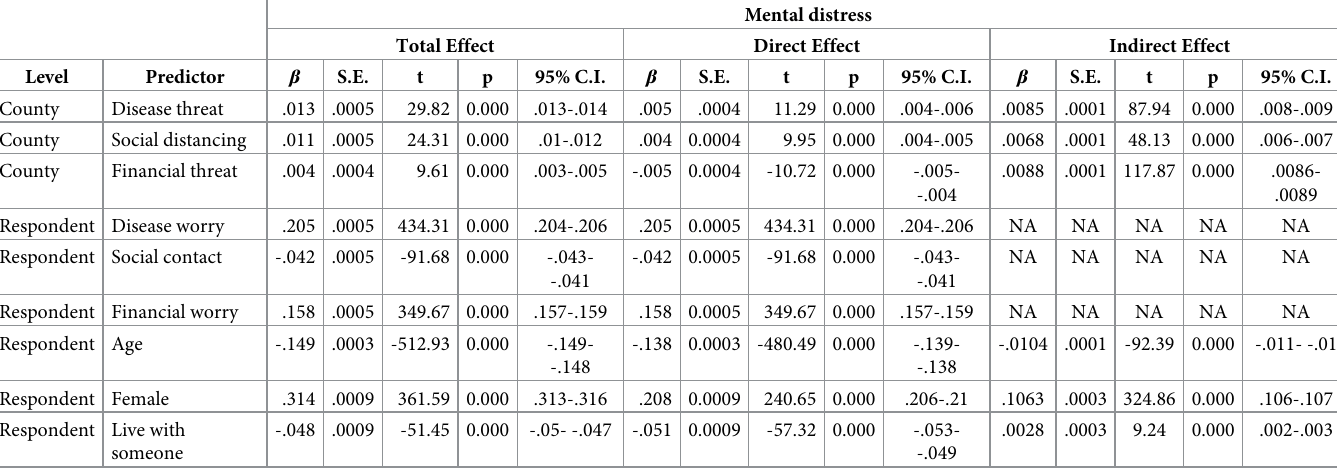
Table 4. Mediation analysis predicting mental distress from county-level and respondent-level variables.